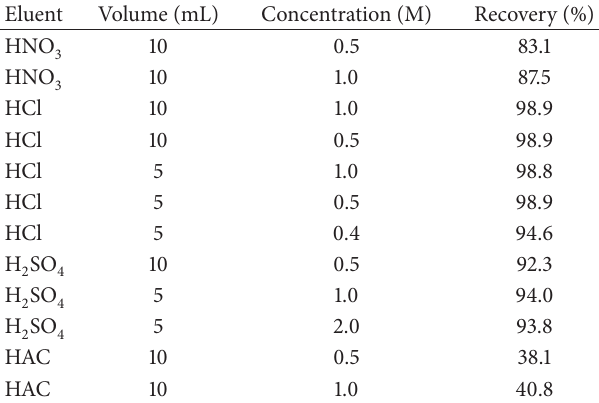
Table 1: Effect of type and concentration of eluting acid on recovery of U(VI) ions ( 𝑛 = 3